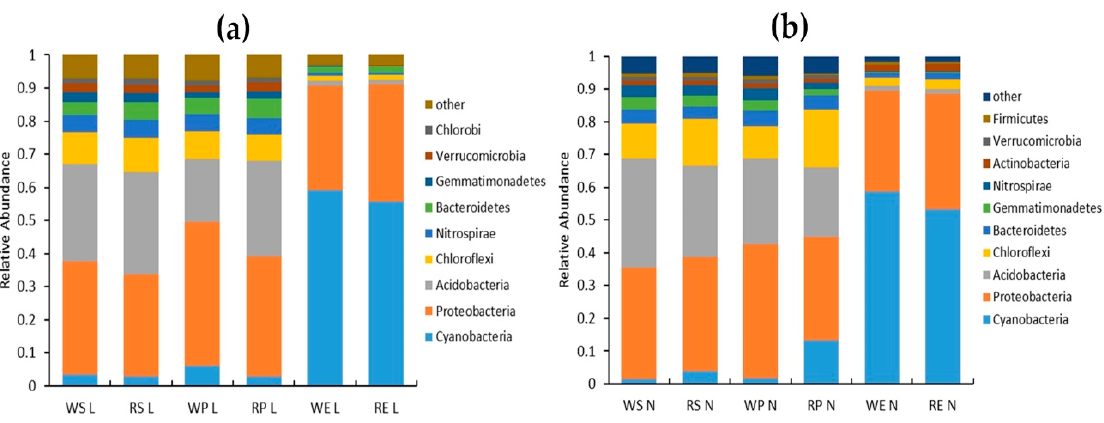
Figure 6. The main phyla of bacteria in rhizo-compartments of rice ( a ) under LN—no nitrogen; and ( b ) under NN—normal nitrogen.